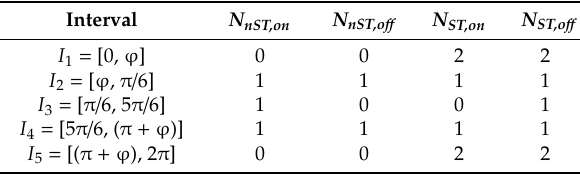
Table 1. The number of the switching transitions for the phase angle between 0 and π / 6. Interval N nST,on N nST,o ff N ST,on